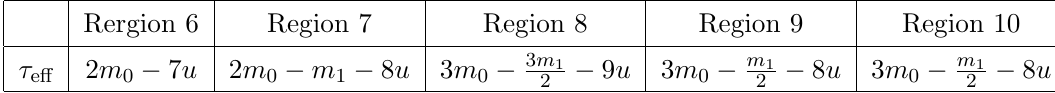
Table 8. The e(cid:11)ective coupling of the E 2 theory ( m 1